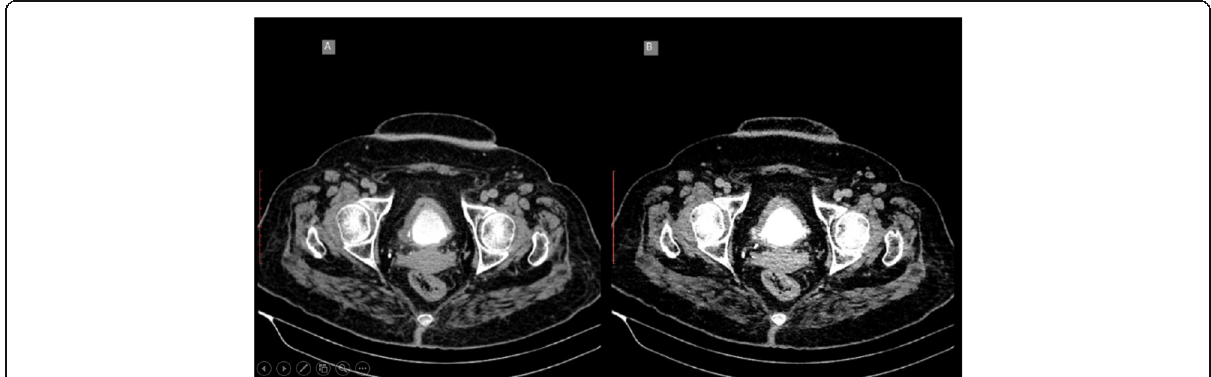
Fig. 2 Female patient, 63 years old,70 kg. a Axial CT urography with standard dose CT protocol A1, SNR were 4.79 and 3.08 at aorta and psoas muscle respectively and CNR were 9.4 and 8.3 at aorta and psoas respectively. b Axial CT urography with low dose with IR protocol B1, SNR were 2.26 and 2.07 and CNR were 6.6 and 5.6 at aorta and psoas, respectively. Both protocols showing diffuse mural thickening which proved to be TCC